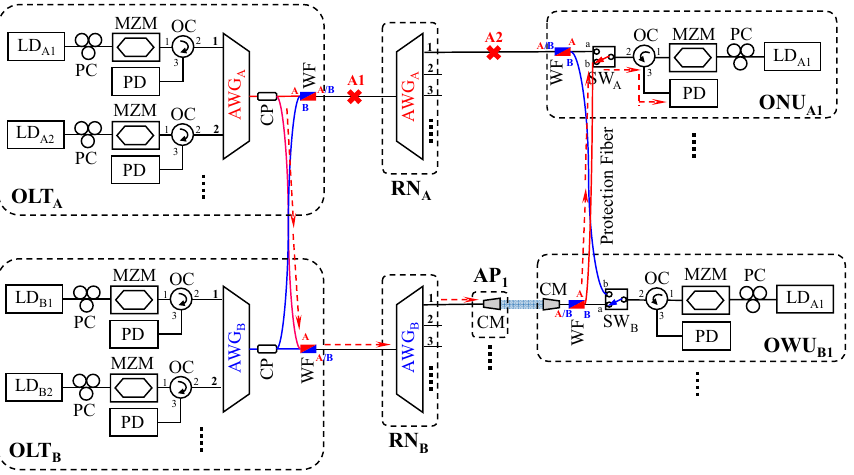
Figure 2. Assume the fiber breakage occurs at the “A1” and “A2” point in the proposed fiber-FSO WDM-PON system, respectively.